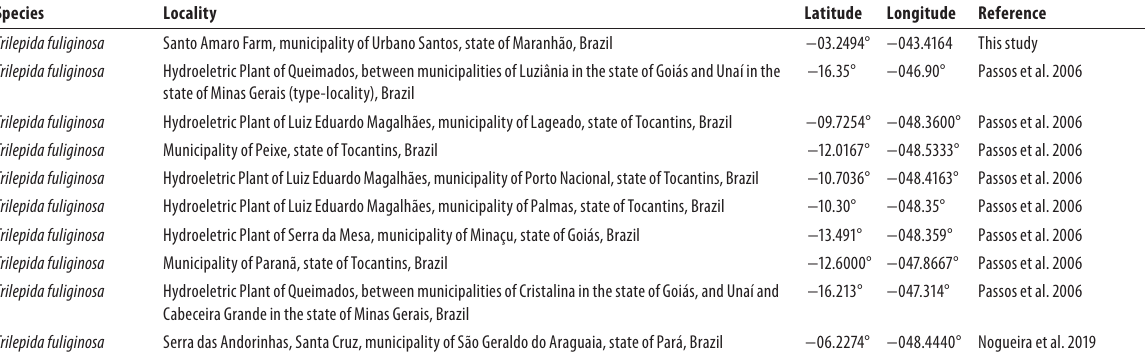
Table 1. Literature and herpetological collection data of occurrences of Trilepida fuliginosa and Drepanoides anomalus in South America. *Prudente et al. (2019) reported an important compilation of museum data. Since we examined only MPEG 21523, and not all specimens of T. fuliginosa in Prudente’s list, we call attention that these data could hide taxonomic